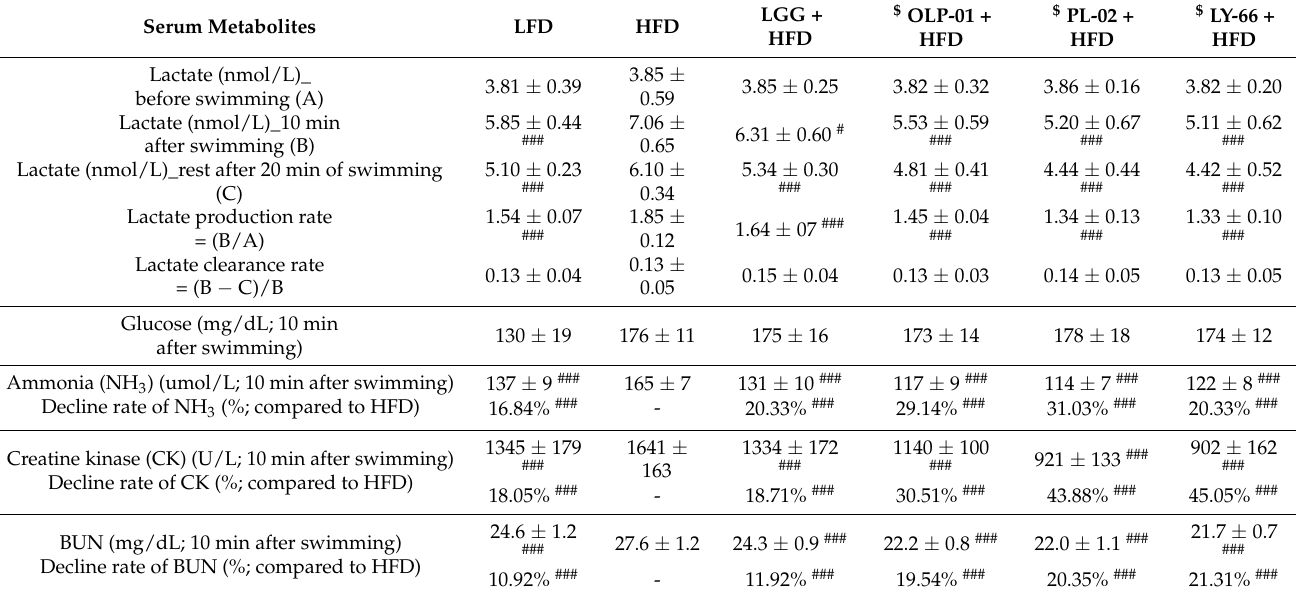
Table 4. Metabolite profiles after the acute swimming